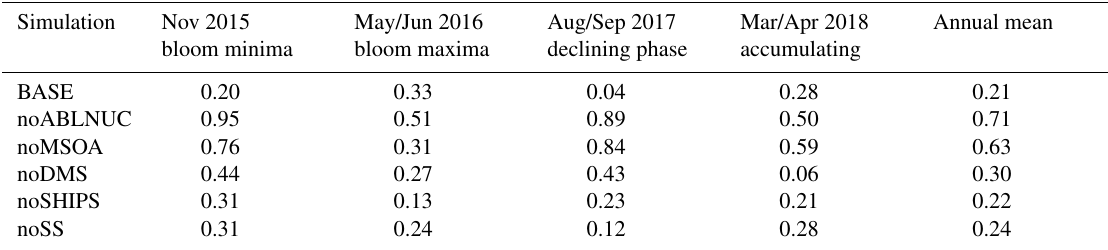
Figure 6. Vertical profiles of NAAMES cruise-track campaign-median observed dimethyl sulfide (DMS) mixing ratios (black, 25th–75th percentiles in grey) from aboard aircraft and for the six GEOS-Chem-TOMAS simulations described in Table 1 (color-coded as shown in the legend). Simulations BASE, noABLNUC, noMSOA, and noSS are nearly coincident. All measurement and model output is binned at 500m resolution, and campaign-median values are plotted at the midpoint of each bin starting at 250m above the surface. Lines show linear interpolation between these values. Note the horizontal scale change between panels. Table 2. Mean fractional error (MFE) between observations and the six GEOS-Chem-TOMAS simulations described in Sect. 2.2 and Table 1 for the ship-track campaign-median aerosol size distributions shown in Fig.